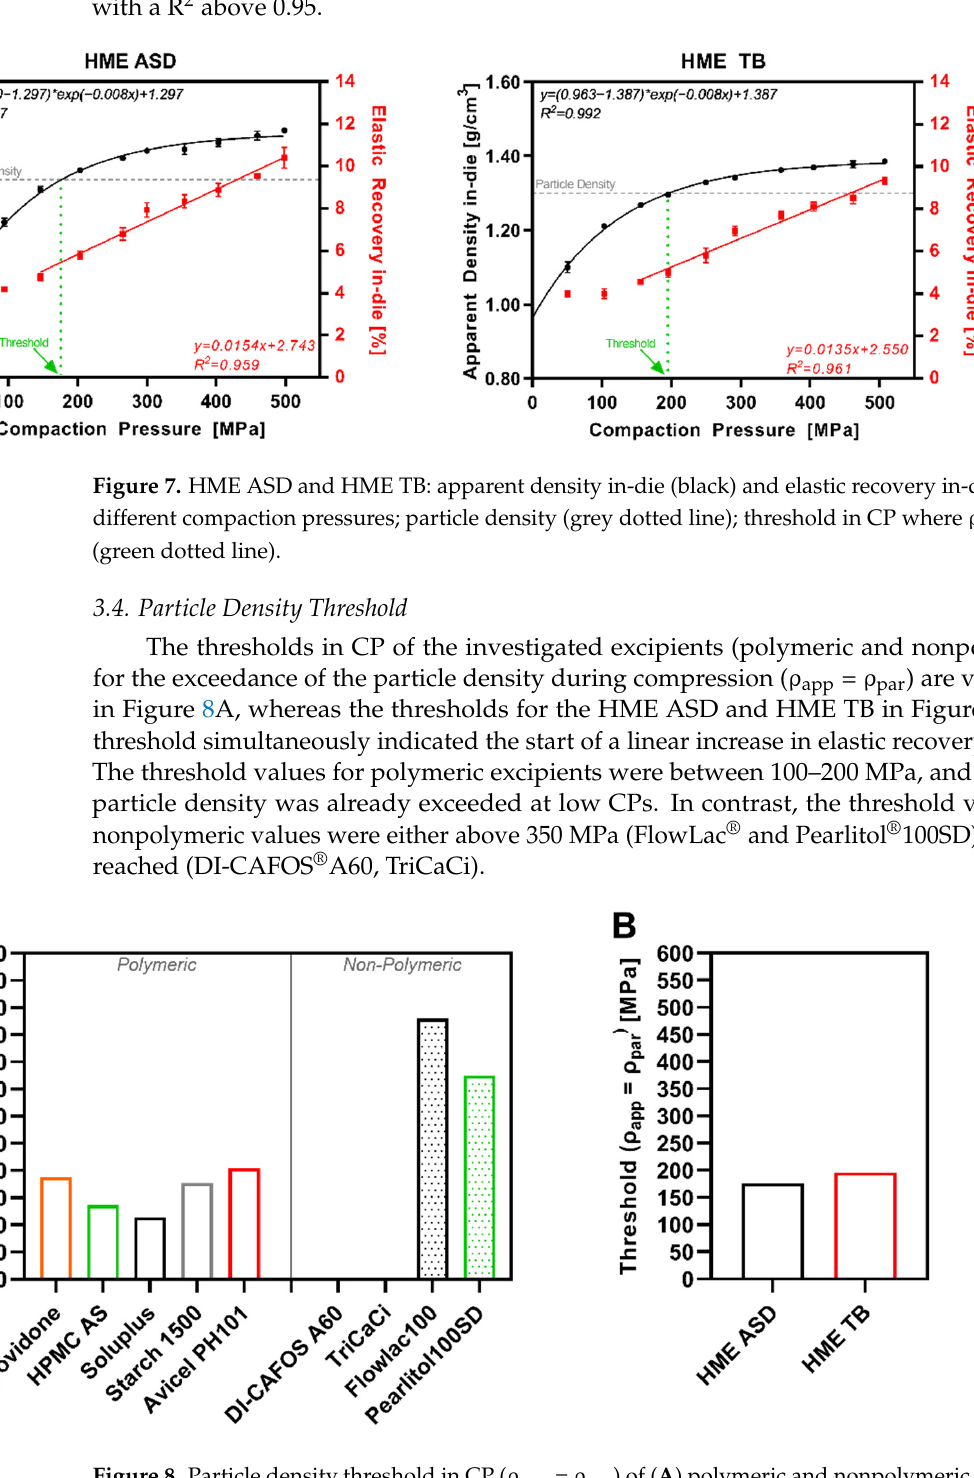
Figure 6. Nonpolymeric excipients: apparent density in ‐ die (black) and elastic recovery in ‐ die (red) at different compaction pressures; particle density (grey dotted line); threshold in CP where ρ app = ρ par (green dotted line).